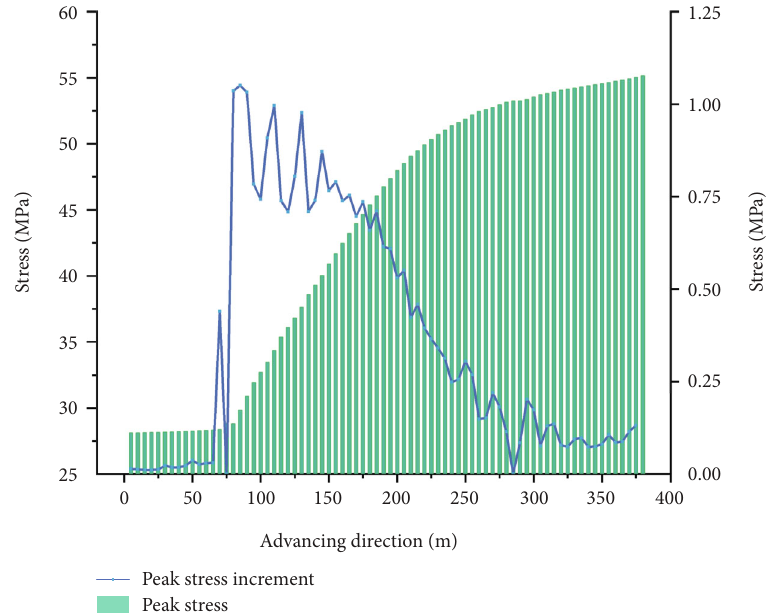
Figure 7: Spatial distribution of stress fi eld in coal pillar.